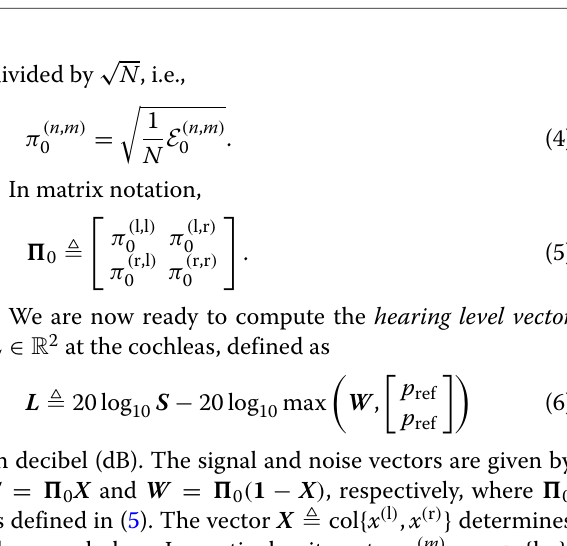
Fig. 1 Illustration of the filter coefficients in (3). The respective cochlea is symbolized by a spiral. Without loss of generality, the left ear in the drawing is referred to as the ipsilateral ear